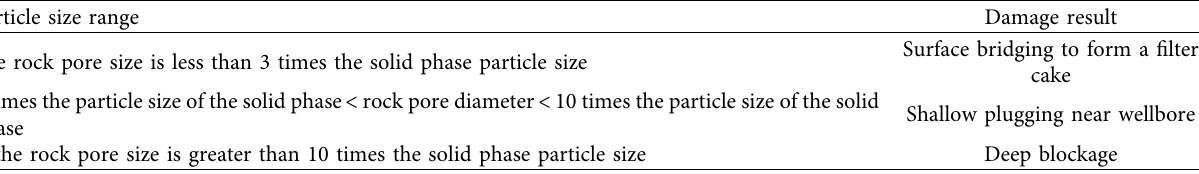
Table 6: Barkman and Abrams blocking